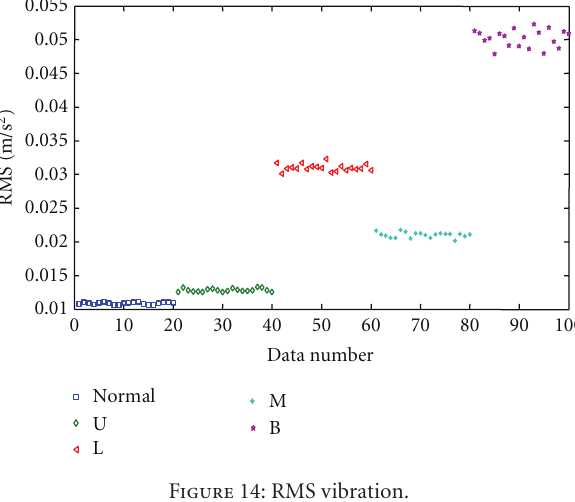
Figure 12: Feature perimeter of thermal image.